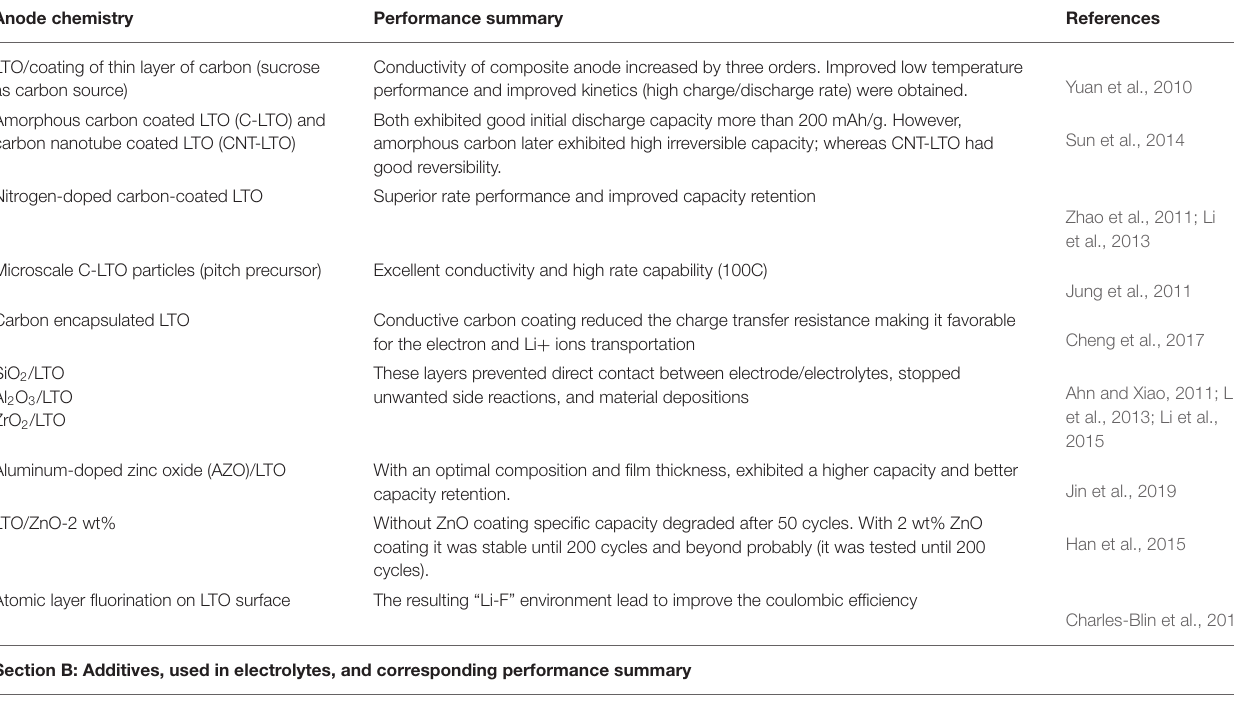
TABLE 1 | Section A: modification and/or coating on the LTO anodes, and corresponding performance summary. Anode chemistry Performance summary